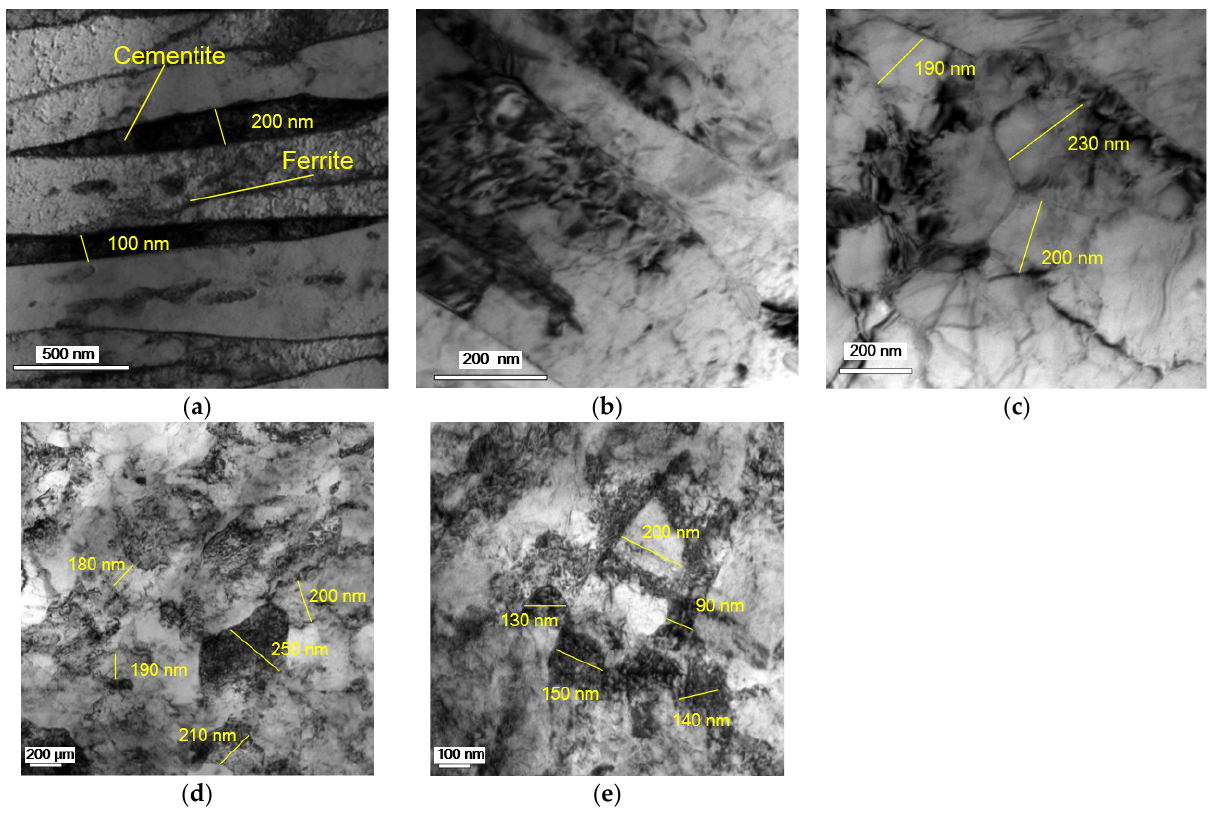
Figure 15. The TEM morphologies of the E690 high-strength steel at laser shock loading at power densities of ( a ) 0 GW/cm 2 , ( b ) 1.53 GW/cm 2 , ( c ) 1.98 GW/cm 2 , ( d )2.77 GW/cm 2 and ( e ) 4.07 GW/cm 2 .